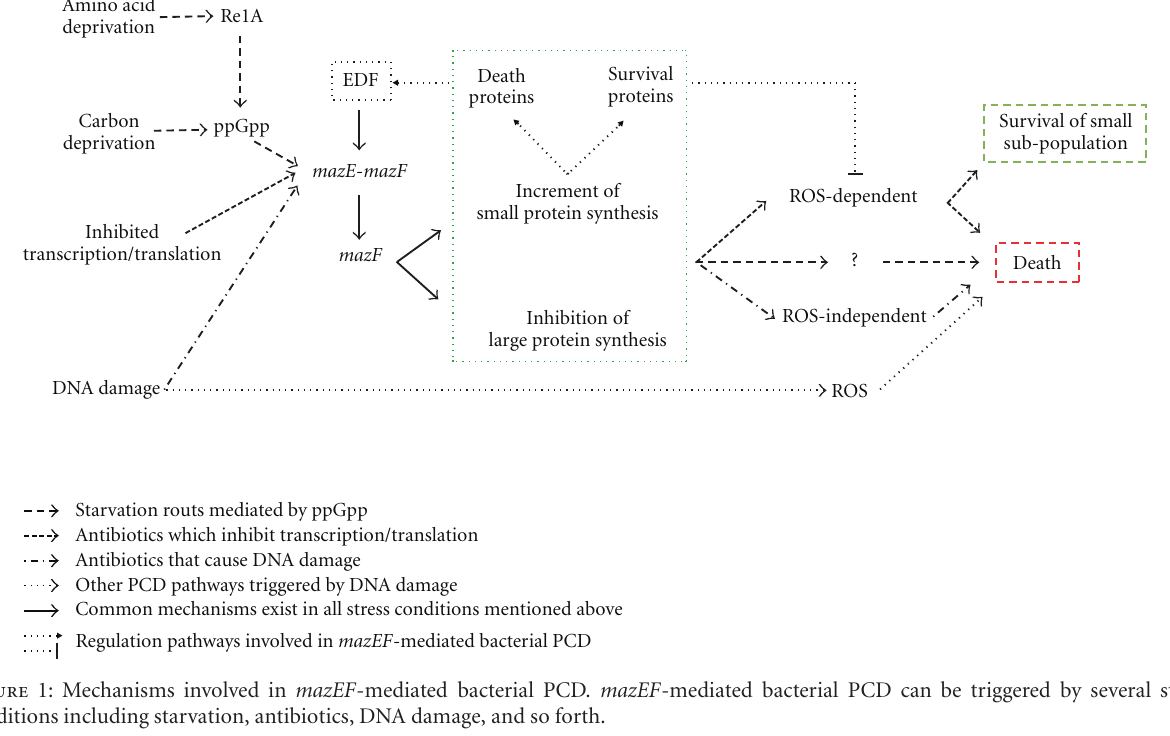
Figure 1: Mechanisms involved in mazEF -mediated bacterial PCD. mazEF -mediated bacterial PCD can be triggered by several stress conditions including starvation, antibiotics, DNA damage, and so